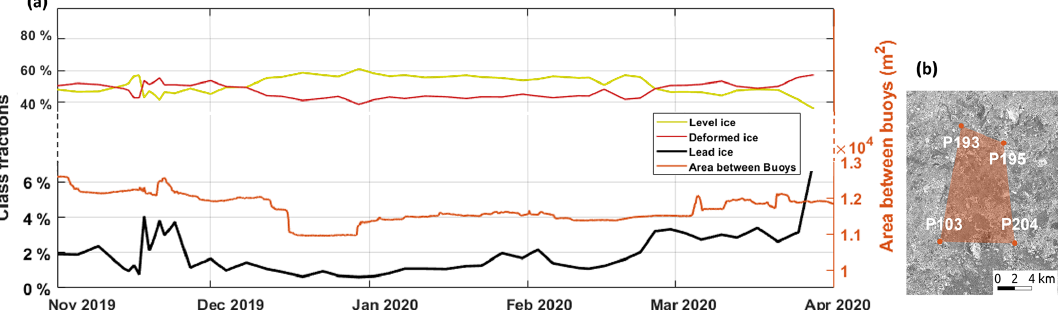
Figure 11. (a) Fractions of level ice, deformed ice, and lead ice (left y axis) as well as the areas between four buoys surrounding the CO (right y axis) over the time series; (b) the names and positions of the four buoys are shown for 1 November